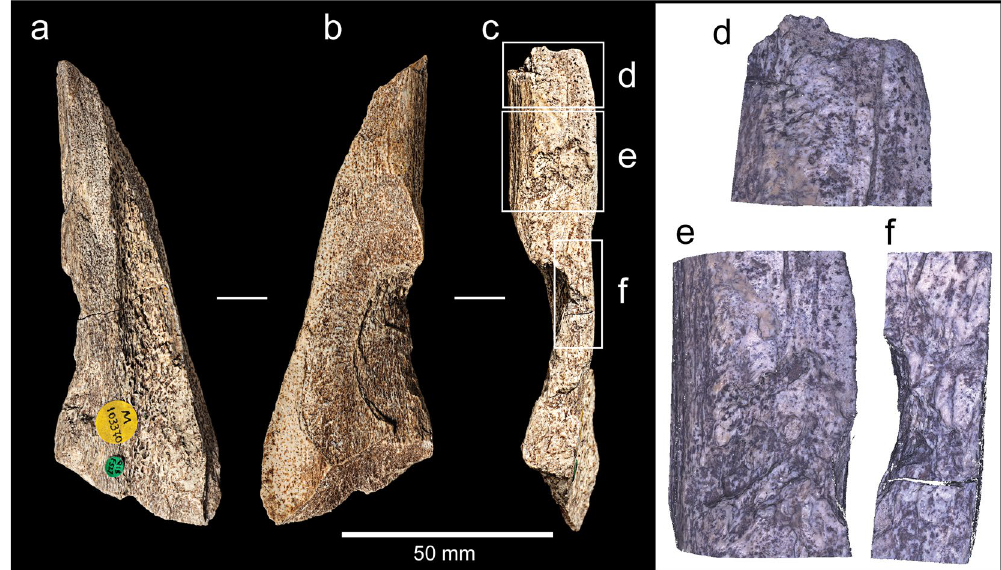
Figure 10. Photographs and Alicona images of a long-bone shaft fragment (NHMUK PV M 103370) from Boxgrove (site Q1/B, find number F527) exhibiting large flake scars associated with knapping damage on the outer cortical surface ( d – f